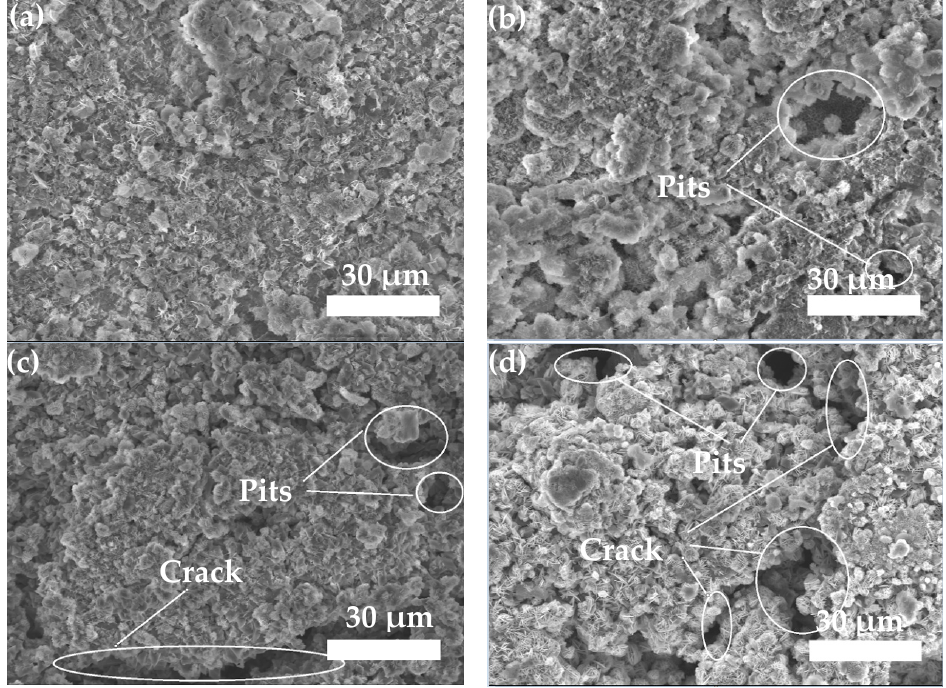
Figure 9. SEM micrographs for the Zn 65 Al 15 Mg 5 ZnO 15 coating after different conditioning periods: ( a )